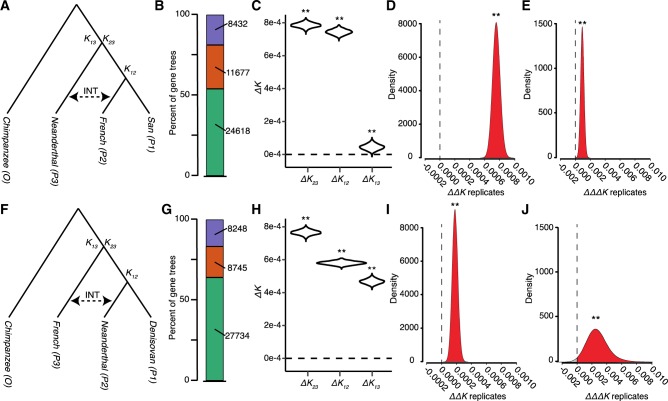
—DIP analysis of hominin introgression. DIP was performed on whole-chromosome alignments of chromosome 1 using two different taxon-sampling schemes (TSS). (A) Depiction of the samples used in TSS1. (B) Neighbor-joining gene-tree topologies from individual loci. (San.,French),Nean.), green; (French, Nean.),San), orange; (San, Nean.),French), purple. (C–E) Results from 1×DIP (C), 2×DIP (D), and 3×DIP (E) applied to TSS1 alignment. (F) Depiction of the sampled used in TSS2. (G) Neighbor-joining gene-tree topologies from individual loci. (Deni.,Nean.),French), green; (Nean.,French),Deni.), orange; (Deni.,French),Nean.), purple. (H–J) Results from 1×DIP (H), 2×DIP (I), and 3×DIP (J) applied to TSS2 alignment. ** indicates significant departure from 0 (P < 0.01).